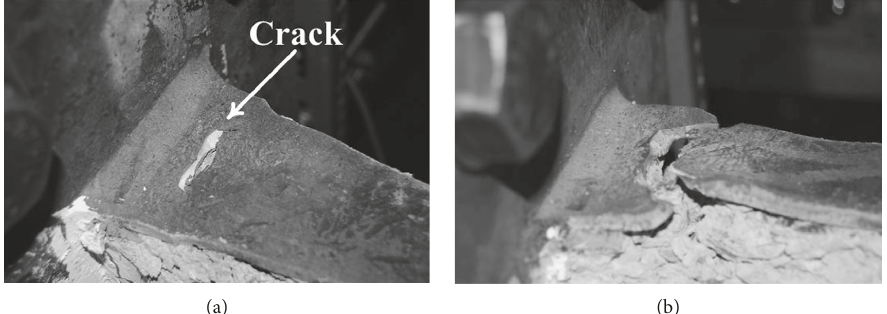
Figure 21: Flange crack and fracture of specimen PW-NB. (a) Beginning of steel flange fracture. (b) Fracture of the steel flange. Table 5: The effectiveness of concrete constraint schemes. Specimen PS-NB PS-MS PS-HS ) P / ( P 0.94 exp exp SC